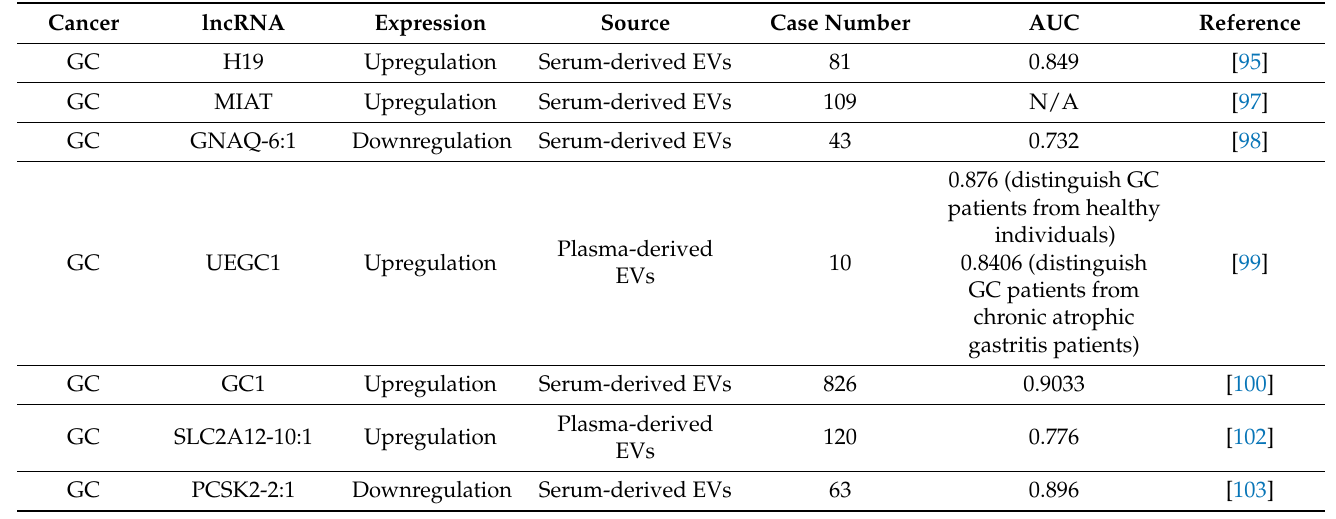
Figure 4. LncRNAs in EVs as new biomarkers for the liquid biopsy of gastrointestinal cancer. Several technologies have been established to isolate EVs from body fluids and detect their cargoes. Many lncRNAs in serum/plasma-derived EVs provide a new strategy for the diagnosis of gastrointestinal cancer. Note: ↑ : Upregulation; ↓ : Downregulation. Table 2. Diagnostic significance of exosomal lncRNAs in gastrointestinal